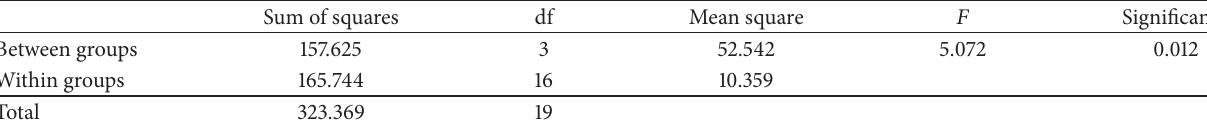
Table 3: ANOVA for collectors with different glass thicknesses.